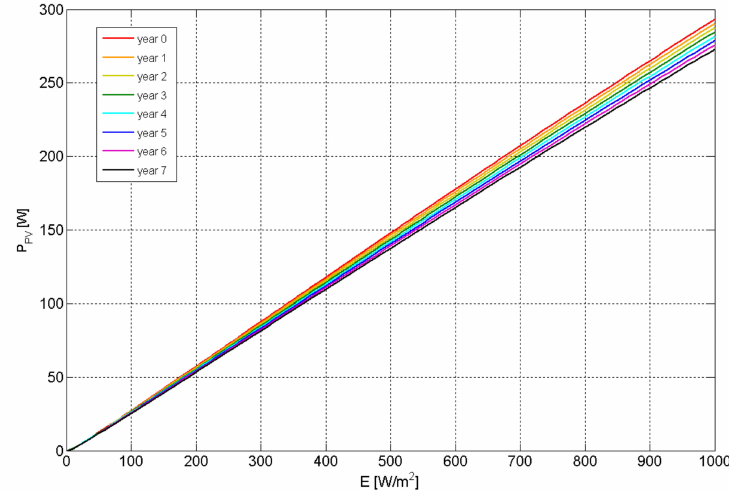
Figure 3. Aging characteristic over seven years for the PV—own